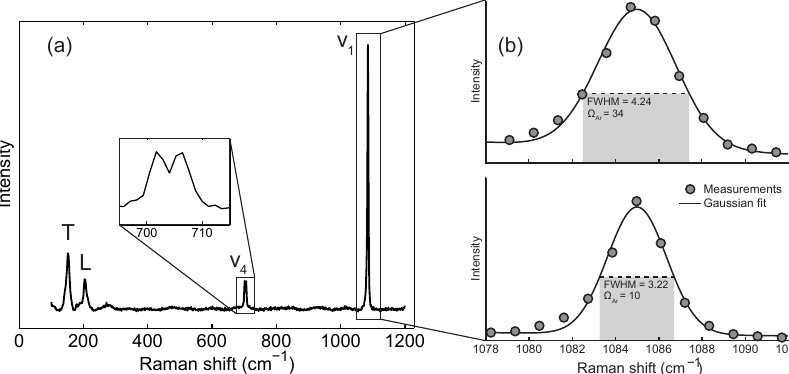
Figure 1. Example Raman spectra and peak width analyses. (a) Raman spectrum of precipitate from experiment f03, with the peaks labelled following White (1974) and Bischoff et al. (1985): T, translation (lattice mode); L, libration (lattice mode); ν 4 , in-plane bend (internal mode); ν 1 , symmetric stretch (internal mode). This spectrum is readily identifiable as CaCO 3 , based on the strong ν 1 peak at approximately 1085cm − 1 , and distinguished as aragonite rather than other CaCO 3 polymorphs (calcite and vaterite) based on the positions of the T, L, and ν 4 peaks (Dandeu et al., 2006). The double peak between 700–710cm − 1 is the feature that most clearly distinguishes aragonite from calcite or vaterite (Urmos et al., 1991). (b) Measurement of ν 1 peak width. The grey points are the measured intensities at the corresponding Raman wavenumber shift. The black lines show the Gaussian curves fit to the data, and the grey boxes indicate the measured peak widths ( ν 1 FWHM). Note that measured ν 1 FWHM is converted to true ν 1 FWHM for analysis in subsequent figures. The y axis scale is in arbitrary intensity